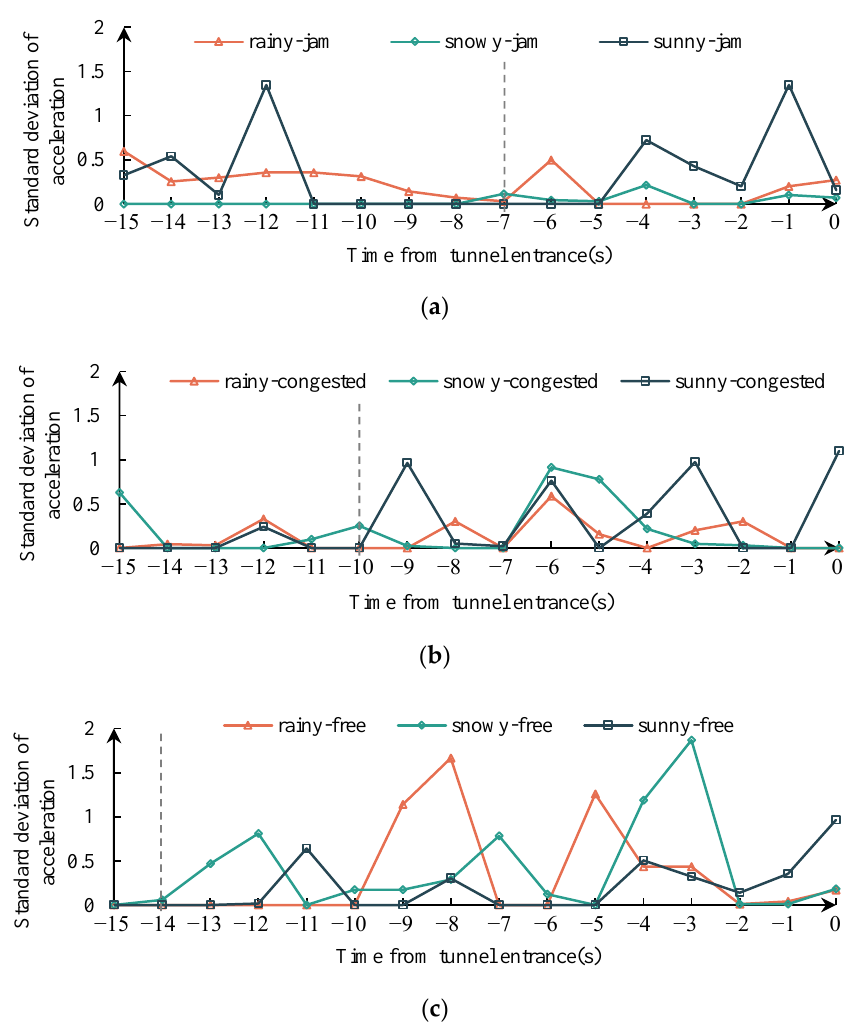
Figure 12. Standard deviation changes of average longitudinal acceleration within 15 s from the tunnel entrance. ( a ) jam flow. ( b ) congested flow. ( c ) free flow.